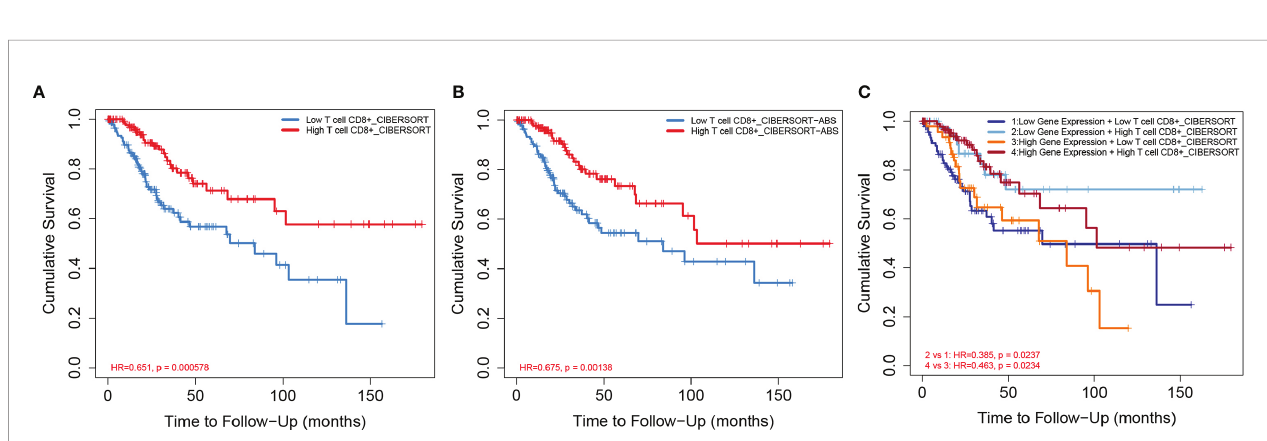
FIGURE 5 | Relationship between CD8+ T-cell in fi ltration and prognosis of CESC. [ (A) CD8+ T-cell in fi ltration level and CESC prognosis based on CIBERSORT algorithm; (B) CD8+ T-cell in fi ltration level and CESC prognosis based on CIBERSORT-ABS algorithm; (C) CD8+ T-cell in fi ltration level and IDO1 expression level and CESC prognosis based on CIBERSORT